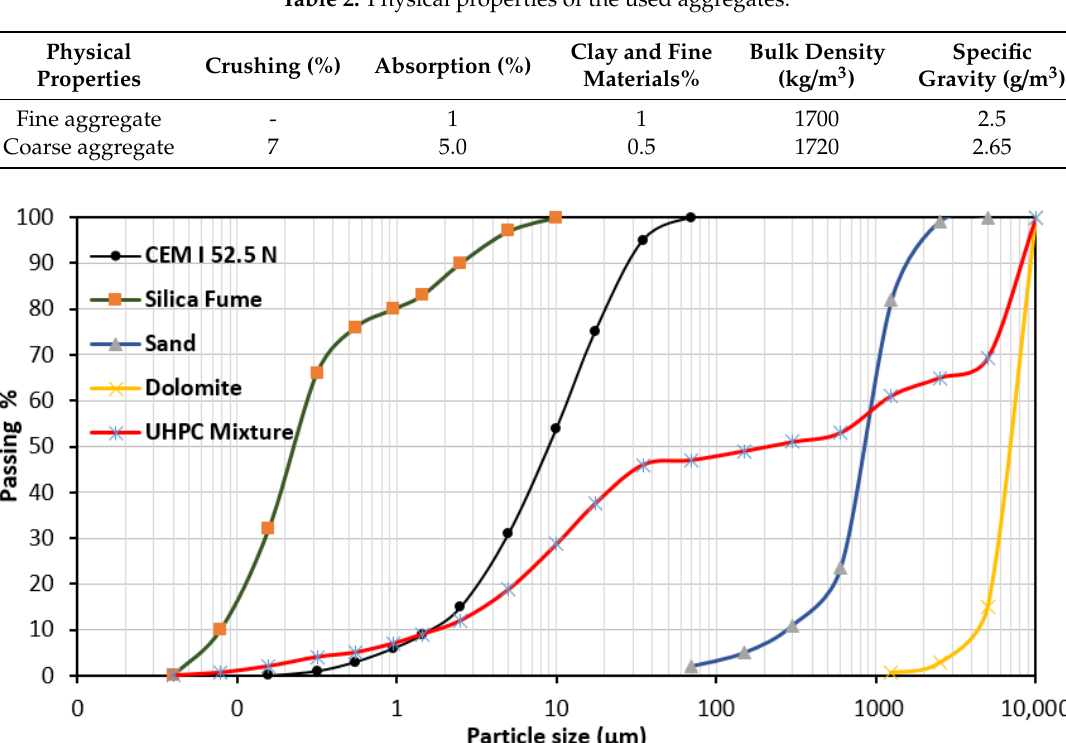
Table 1. Physical properties and chemical composition used fine materials.